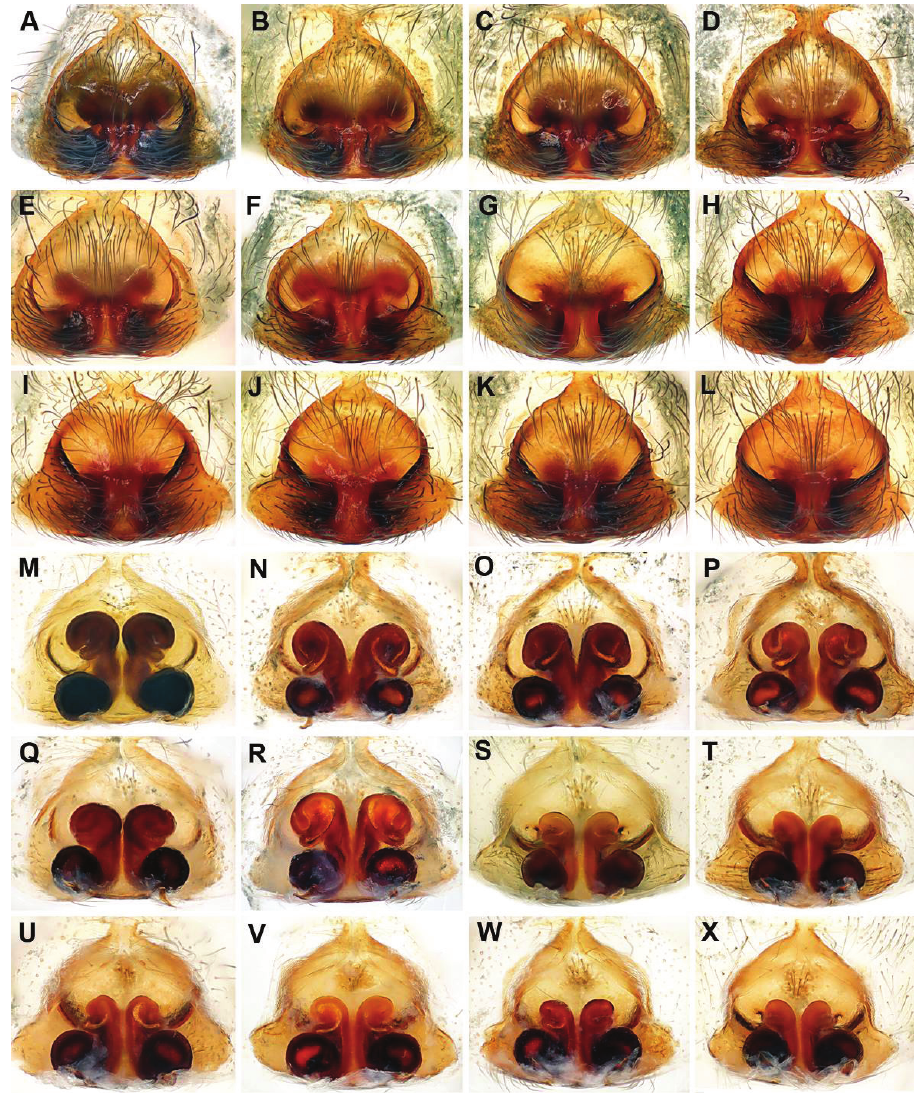
Figure 5. Longicoelotes geei sp. n. ( A–F, M–R) and L. kulianganus ( G–L , S–X) , variations in shape of epigynal atrium and size of copulatory ducts. A–L Epigyne, ventral view M–X Vulva, dorsal view. Female: Total length 6.75. Carapace 2.75 long, 2.15 wide. Abdomen 4.00 long, 2.25 wide. Eye sizes and interdistances: AME 0.15, ALE 0.15, PME 0.16, PLE 0.13; AME-AME 0.06, AME-ALE 0.05, PME-PME 0.10, PME-PLE 0.10. Leg measure- ments: I: 10.50 (3.00, 3.50, 2.50, 1.50); II: 9.20 (2.75, 3.00, 2.25, 1.20); III: 8.70 (2.50, 2.70, 2.25, 1.25); IV: 12.00 (3.50, 3.75, 3.25, 1.50). Carapace greenish, with black lateral margins, the radial grooves distinct; sternum with light stripes.